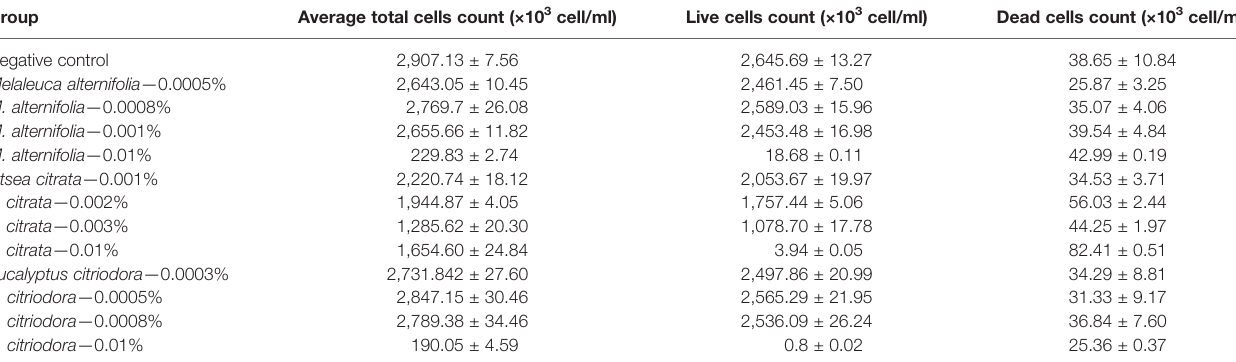
TABLE 5 | Average total cells count, live cells count, and dead cells count of Vibrio campbellii with or without essential oils at different concentrations, obtained from fl ow cytometer.